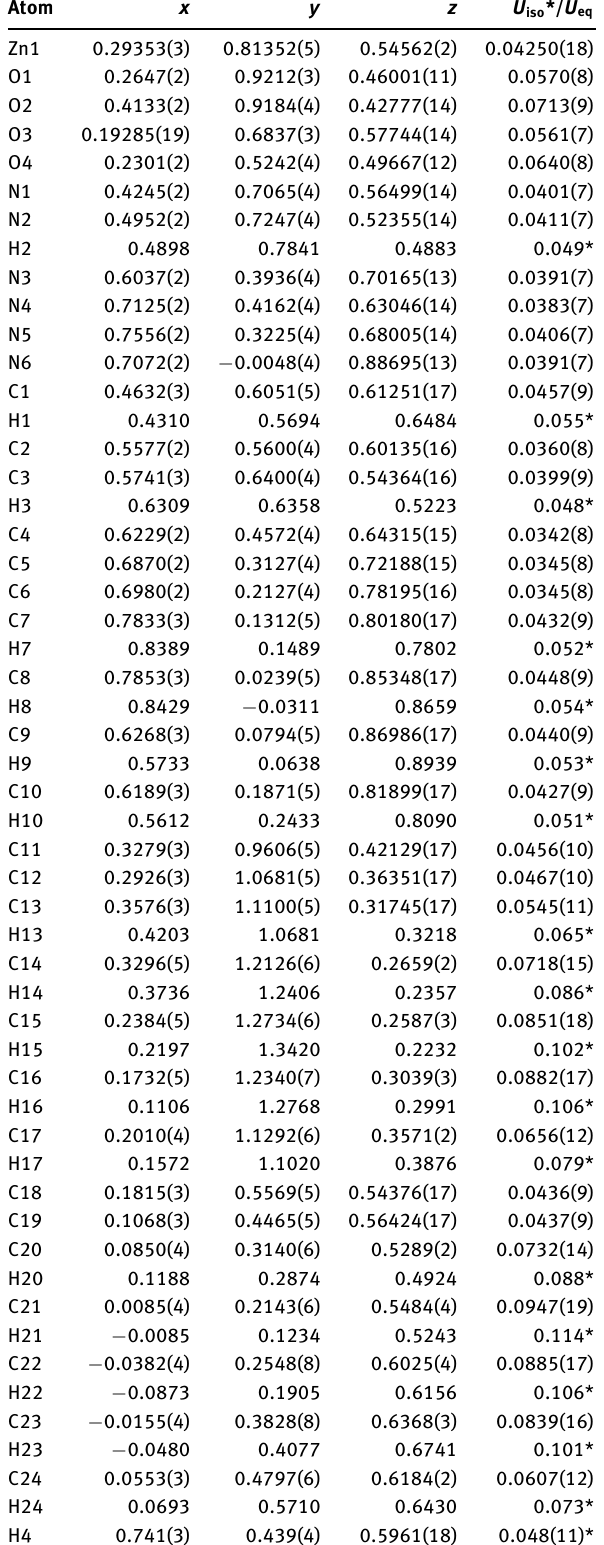
Table 2: Fractional atomic coordinates and isotropic or equivalent isotropic displacement parameters (Å 2